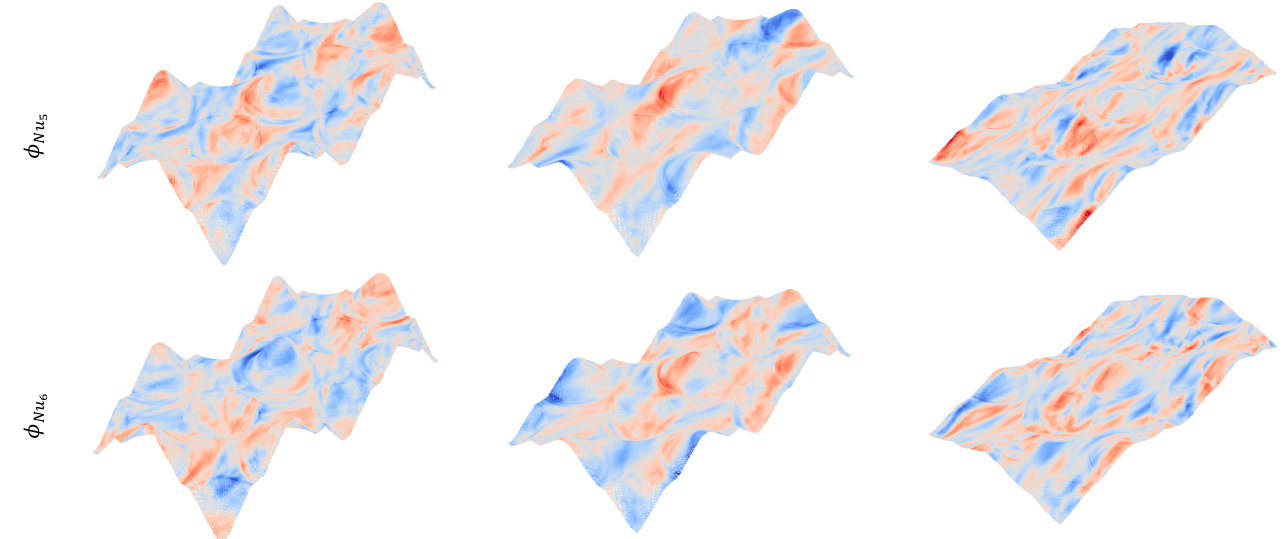
Figure 10. Nu mode variance distribution for the first 1000 modes and the first six POD modes of Nu corresponding to the three levels of roughness height.